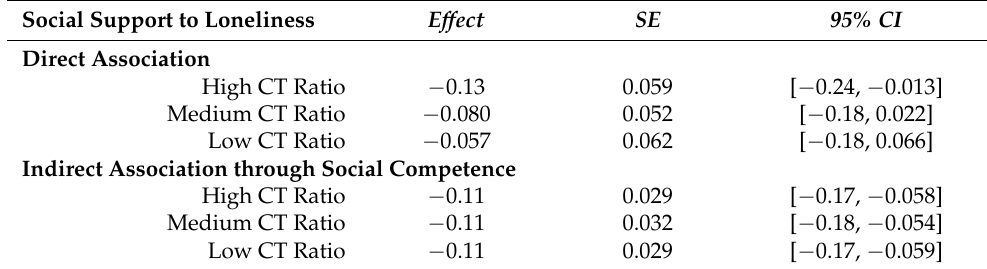
Table 3. The conditional association between social support and